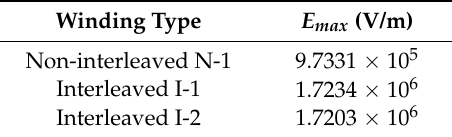
Table 4. Maximum electric field intensities.